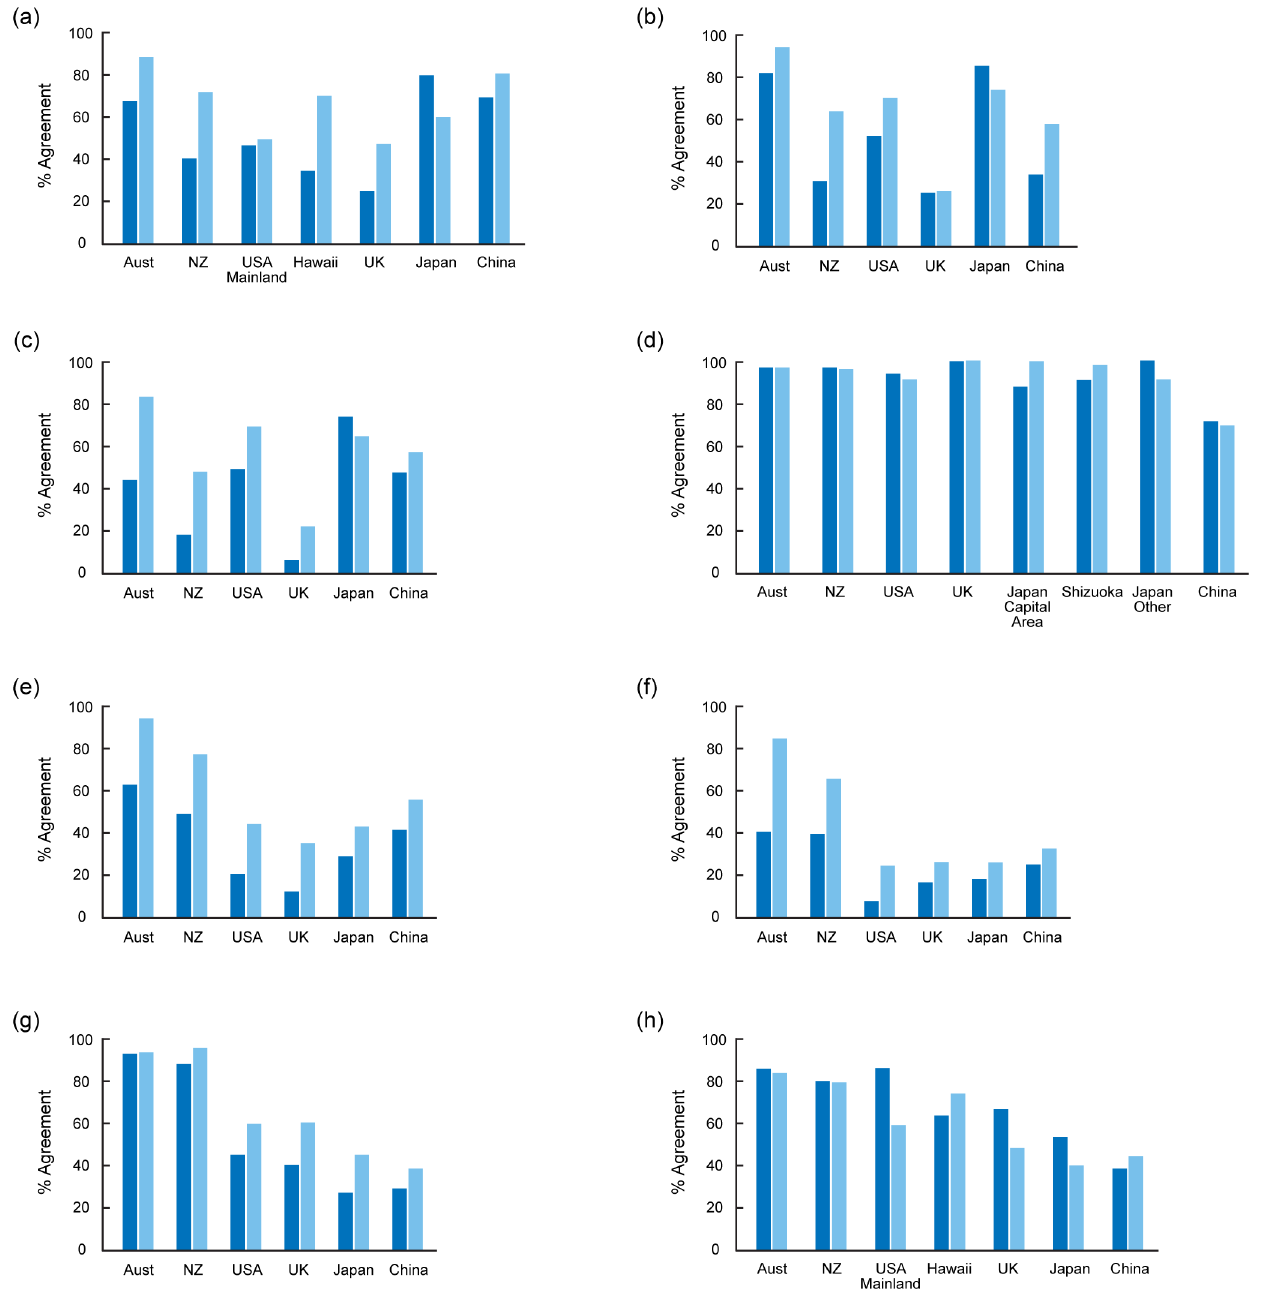
Fig 1. Percentage agreement of cat owners (dark blue) and non-owners (light blue) in each country to eight survey items: (a) There is a need for cat legislation (b) All cats should be kept in at night time (c) Cats should be kept on their owner's property at all times (d) It is important to have wildlife in cities, towns and rural areas (e) Pet cats killing wildlife in cities, towns and rural areas is a serious problem (f) Pet cats on farms are harmful to wildlife (g) Pet cats in nature reserves are harmful to wildlife (h) Except for a cat owned by a breeder, all cats should be desexed. owners, with Japan and China forming a third group with support c. 30% for owners and 40% for non-owners. For owners and non-owners from Australia, New Zealand, the UK and the USA, support for this item was consistently higher than for 'Pet cats killing wildlife in cities, towns and rural areas is a serious problem' and 'Pet cats on farms are harmful to wildlife.'